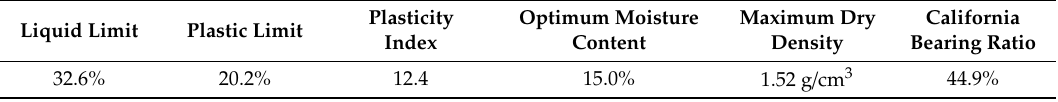
Table 6. Physical properties of modified